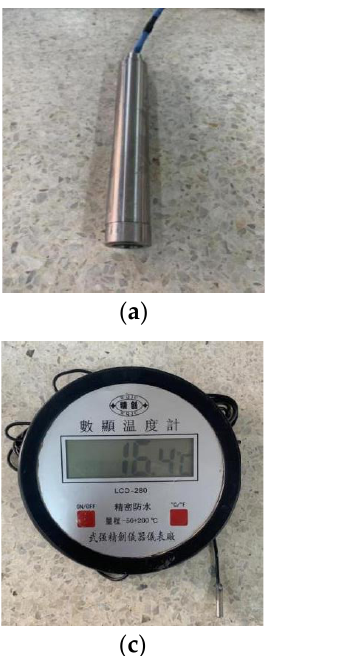
Figure 5. Measuring equipment. ( a ) Pore water pressure gauge; ( b ) digital display instrument; ( c ) thermometer; ( d ) dial gage.